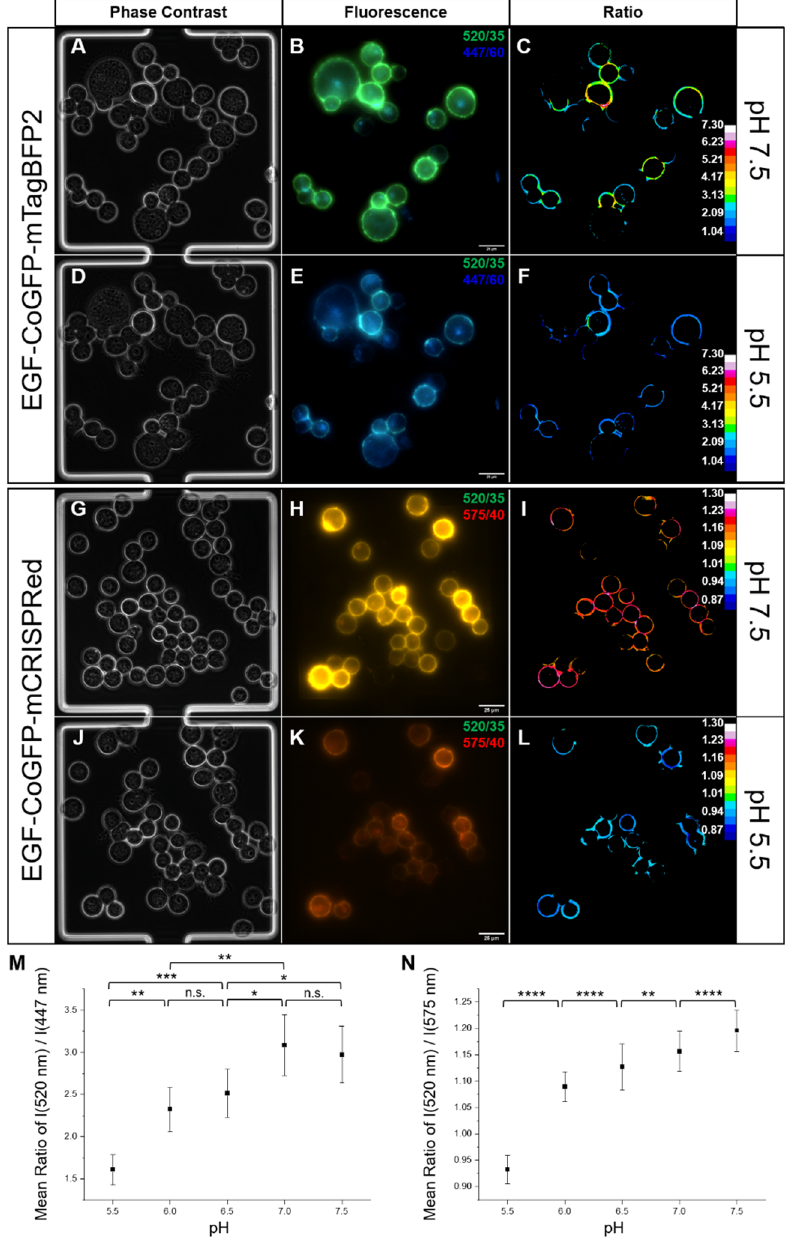
Figure 6. The molecular pH sensors were used in a microfluidic device for single-cell cultivation. EGF-CoGFP-mTagBFP2 ( A – F ) or EGF-CoGFP-mCRISPRed ( G – L ) bound to 293-F cells expressing the EGFR ectodomain on the cell surface upon incubation. Cells were seeded into the cultivation chambers of the microfluidic device and incubated for 3 h at 22 °C. After 1 h of incubation, cell culture medium at five different pH values was sequentially changed with 5 µL/min and analyzed after 20 min of incubation by fluorescence microscopy. Representative images show the same chambers at pH 7.5 ( A – C , G – I ) and pH 5.5 ( D – F , J – L ) as phase-contrast images ( A , D , G , J ) and overlay fluorescence images of 520/35 and 447/60 nm emission ( B , E ) or 520/35 and 575/40 nm emission ( H , K ). Pseudo-colored images represent emission ratios 520 nm/447 nm ( C , F ) and 520 nm/575 nm ( I , L ) calculated from the fluorescence detected solely from the cell surface. For each pH step (5.5, 6.0, 6.5, 7.0, 7.5) the mean ratio among all cells of nine chambers was plotted for EGF-CoGFP-mTagBFP2 (( M ), n = 72–80, ±SEM) and EGF-CoGFP-mCRISPRed (( N ), n = 150–217, ±SD). * p < 0.05; ** p < 0.01; *** p < 0.001; **** p < 0.0001, unpaired two-sided t -test. A different approach to avoid redesigning the microfluidic device is the absorbance measurement of phenol red-containing medium, which is limited to a pH range of 7 to 8